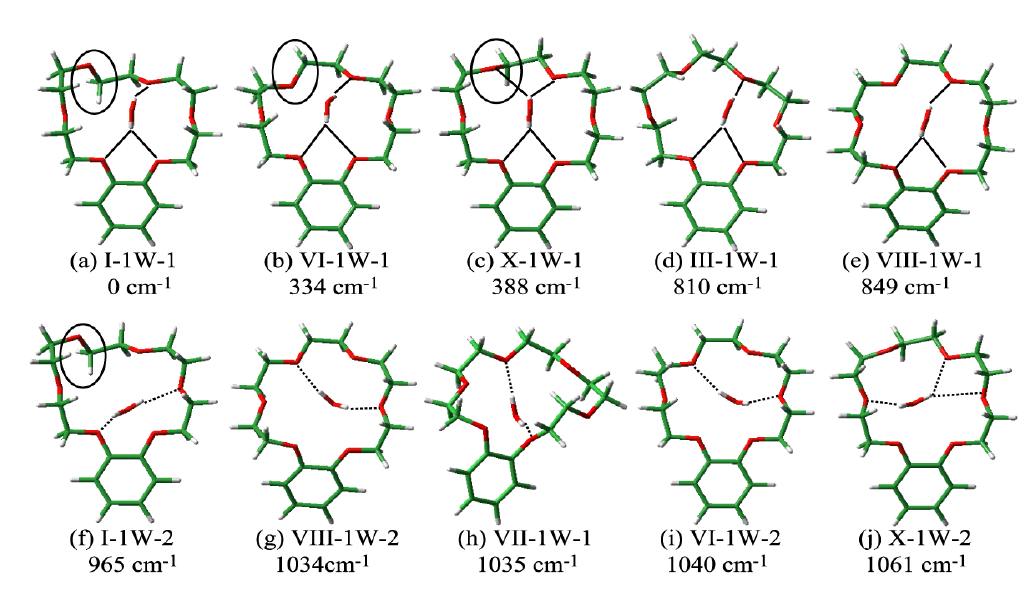
O) at the B3LYP/6-31+G* level. The 2 1